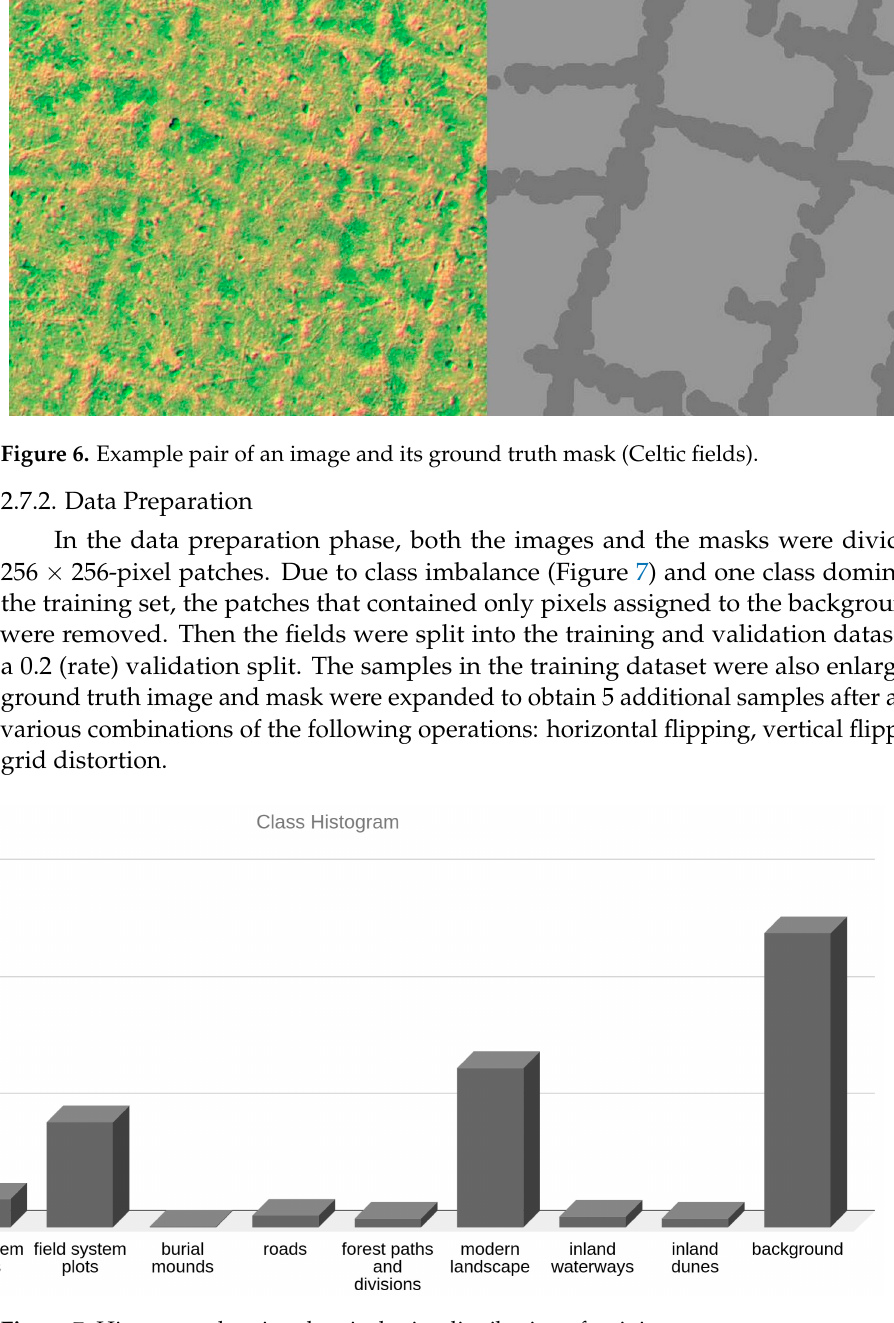
Figure 7. Histogram showing the pixel ‐ wise distribution of training set.